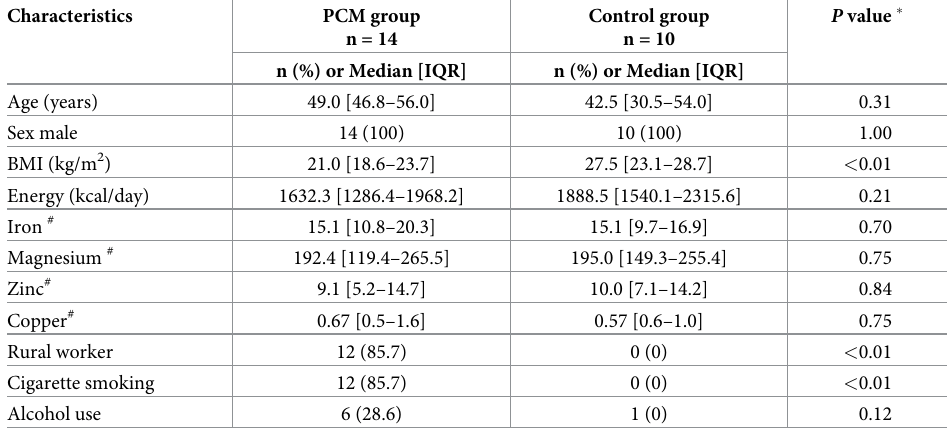
Table 2. Characteristics of 14 patients with paracoccidioidomycosis (PCM group) and a control group of 10 healthy subjects.